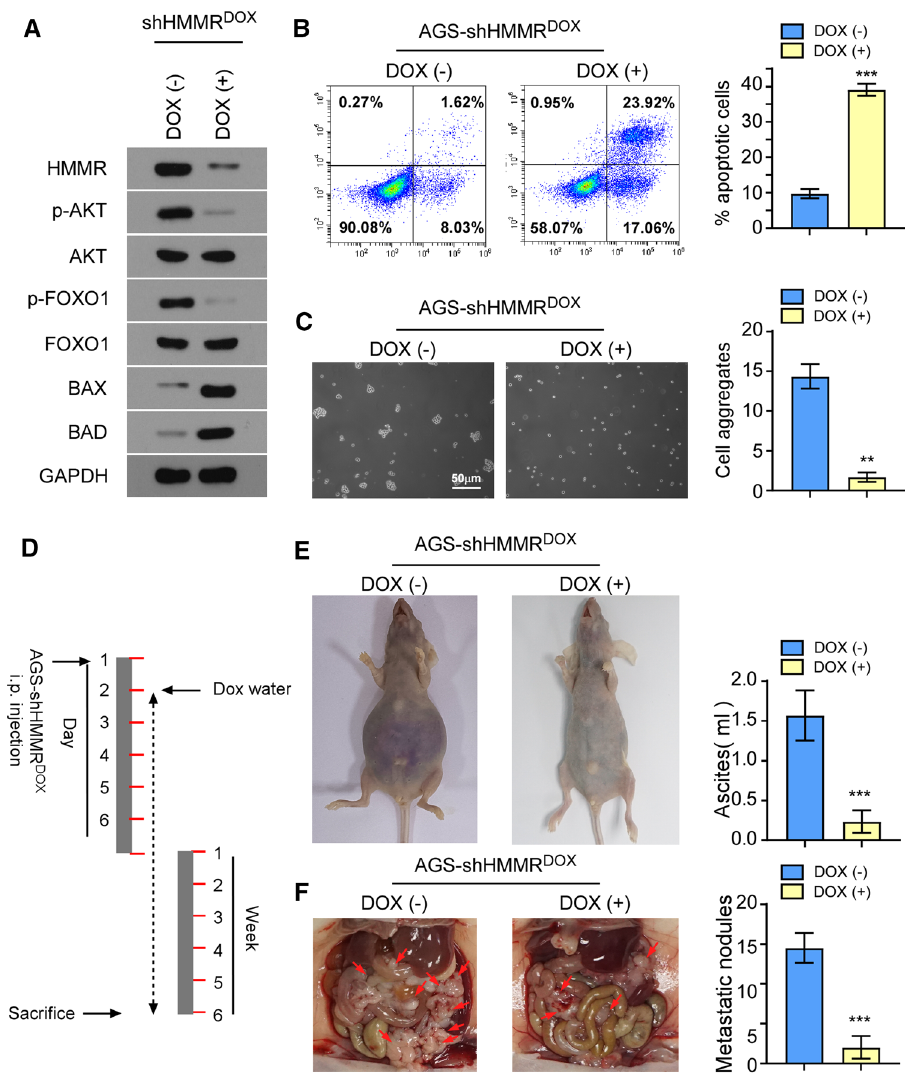
Fig. 5 Inducible silencing of HMMR abrogates peritoneal implantation of gastric can- cer. A Immunoblot analysis of HMMR and critical genes of AKT/FOXO1 signaling path- way (p-AKT, AKT, p-FOXO1, FOXO1, BAX, BAD) were per- formed in indicated groups. B The percent of anoikis cells in indicated groups were shown. C Representative images of cell clustering formations in indicated groups were shown. D Scheme of Dox induced mouse model. Dox-induced silencing of HMMR was performed the day after i.p inoculation. E Bloody ascites were observed 6 weeks after i.p inoculation. F Mice were sacrificed to examine the peritoneal dissemination 6 weeks after i.p inoculation. The number of tumor nodules were quantified. Each bar rep- resents the mean ± SD of three independent